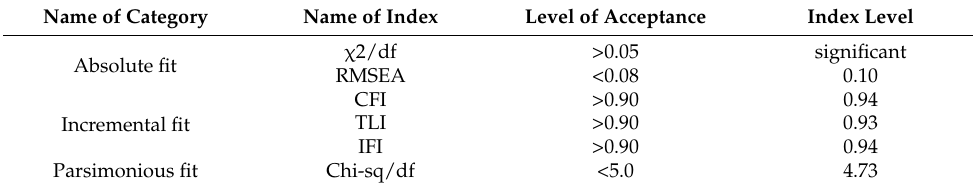
Table 6. Index level for the revised model.